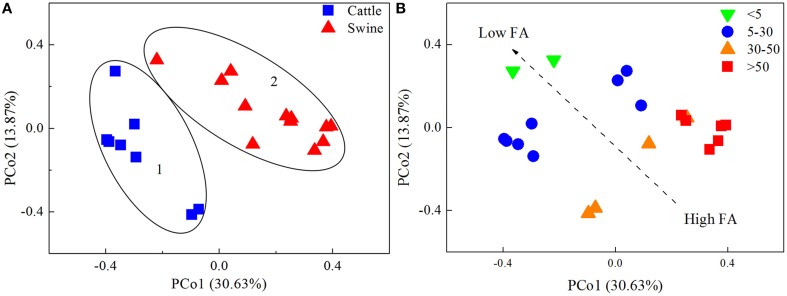
The principal coordinates analysis (PCoA) plots of the bacterial communities in 20 independently-operated full-scale anaerobic digesters. Bray-Curtis distance was used for the PCoA analysis. Plots were ranked by (A) substrate type, and (B) free ammonia content (FA, mgl−1).